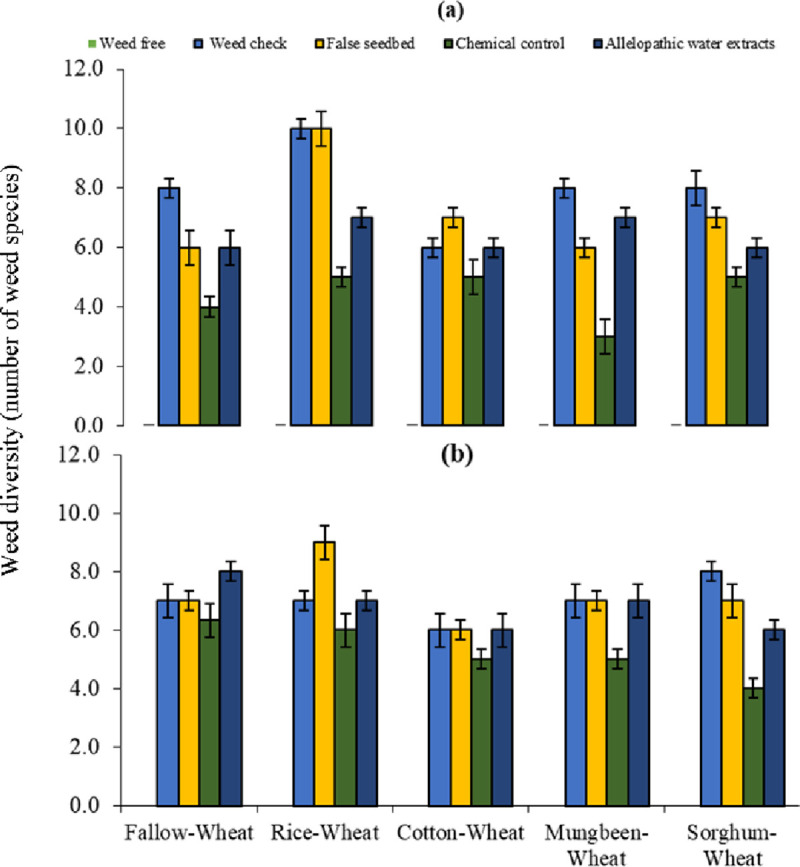
Effect of different weed management strategies on weed diversity (number of weed species) under different wheat based cropping systems during (a) 2012–2013 and (b) 2013–2014 ± S.E.